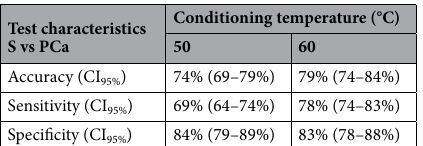
Table 1. Comparison of eNose diagnostic performance based on the analysis of urine headspaces enriched at 50 °C and 60 °C.